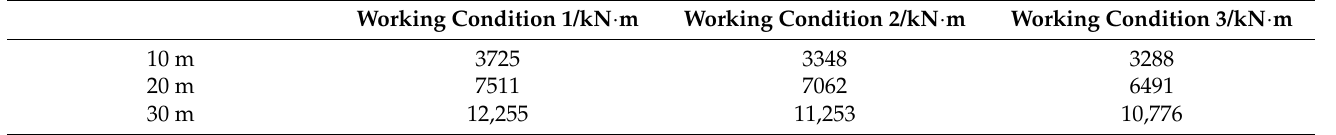
Table 6. The total weight share of each model in the traffic